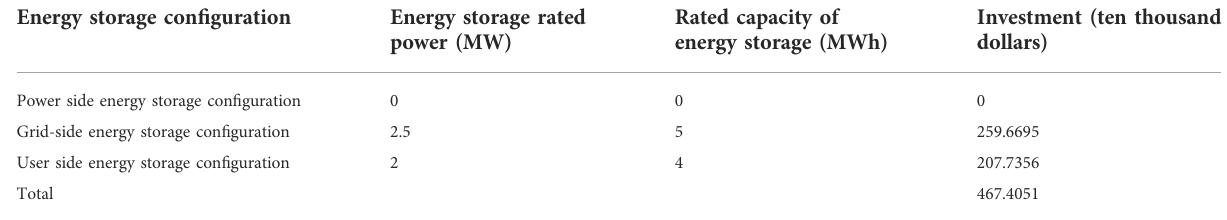
TABLE 8 Calculation results of investment scale on the energy storage